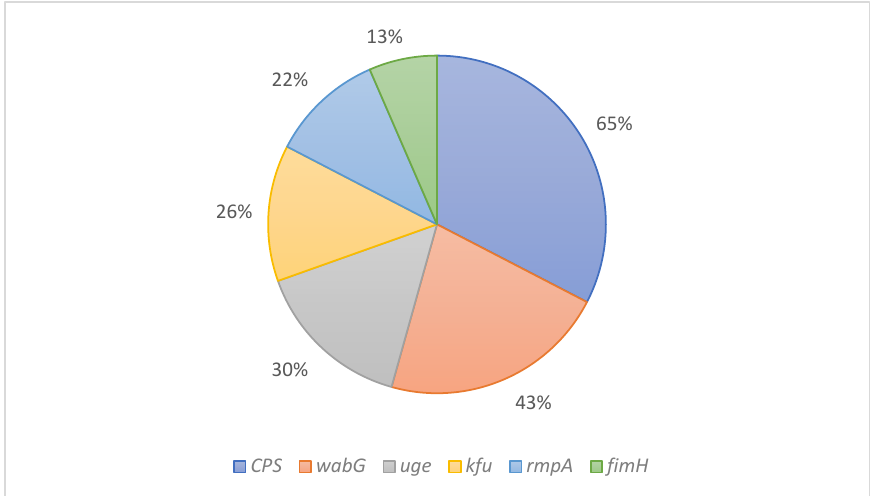
Figure 2. The percentage of virulence factors in K. pneumoniae KPC isolates. The capsular polysaccharide gene (i.e., CPS ) is a shared gene within K. pneumoniae isolates [29]. One study showed that this gene was present in all isolates (100%) of the study ( n = 65 isolates) [47], while it appeared in 65% of our study isolates. wabG gene in K. pneumoniae is a virulence factor involved in the attachment of bacterium to host tissues [48], and it is present in 43% of the isolates in this study. Another study conducted on 23 samples in Saudi Arabia isolated from 2011 to 2015 showed that the prevalence of the Kfu carrying the kfu gene to 26%. In recent years, few studies in Saudi Arabia shed light on the